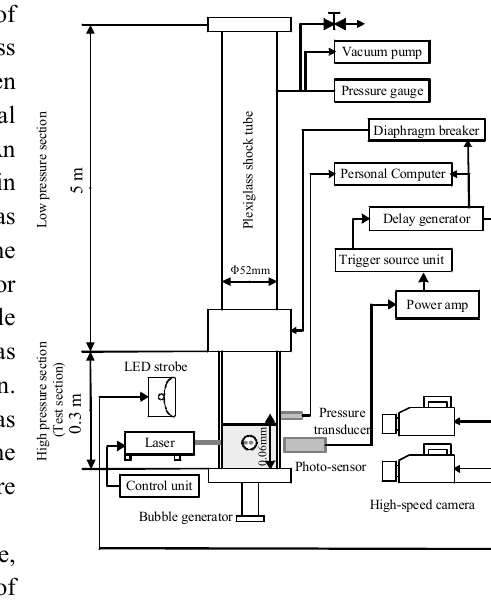
Fig. 1 Experimental